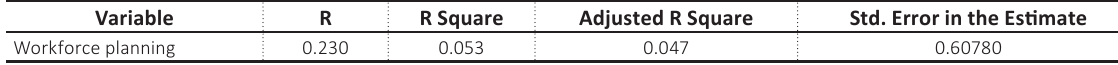
Table 5. Model summary for H1.1